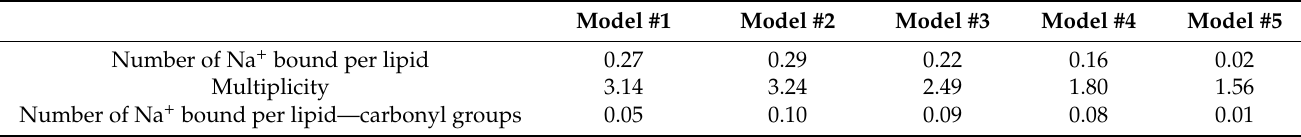
Table 6. Number of interactions between sodium ions and